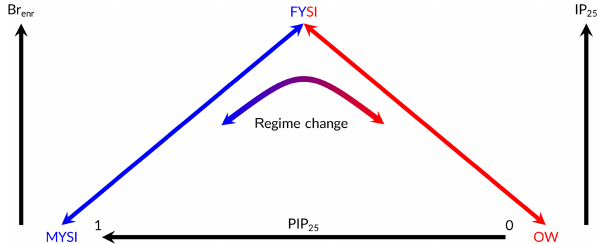
Figure 5. Schematic illustration of marine and (suggested) ice- core-based sea ice indicators as a function of different sea ice con- ditions. Br enr (ice core) and IP 25 (sediment core) increase as a func- tion of first-year sea ice (FYSI) area. Low values can thus indicate either open-water (OW) or multi-year sea ice (MYSI) conditions, depending on the climate state. The PIP 25 index is a marine-derived semi-quantitative indicator of local sea ice conditions at the marine core location. PIP 25 ∼ 0 (PIP 25 ∼ 1) indicates open-water (peren- nial sea ice, i.e. MYSI) conditions, while intermediate PIP 25 values reflect seasonal sea ice (i.e. FYSI). Br enr values in the RECAP core are believed to indicate an FYSI/OW regime in a “warm” climate state and an FYSI/MYSI in a “cold” climate